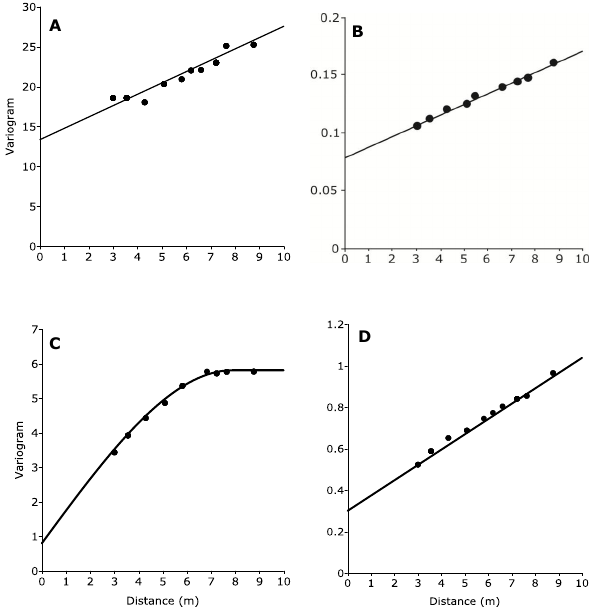
Fig. 9. Omni-directional variograms calculated for ash thickness distributions at (A) , 4; (B) 16; with Ln data, (C) 34; and (D) 45 days after the fire.